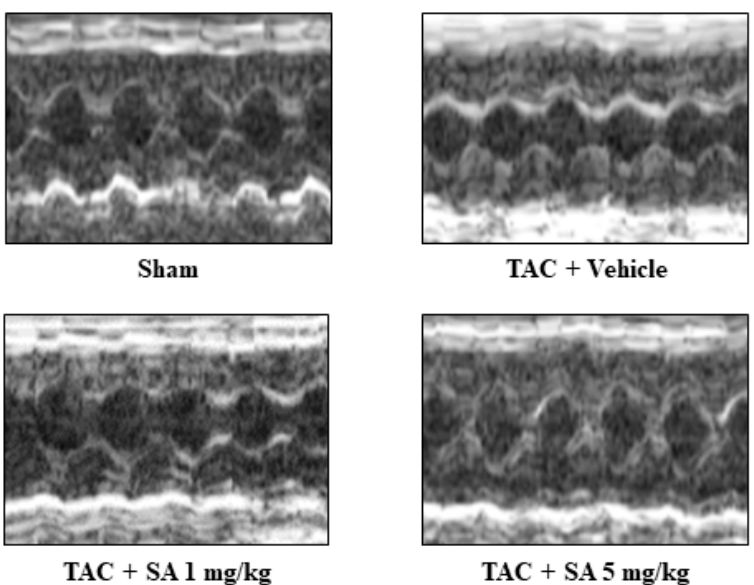
Figure 3. Sarpogrelate suppressed TAC-induced cardiac hypertrophy and systolic dysfunction in vivo. Eight weeks after TAC surgery, cardiac hypertrophy and cardiac function were assessed by echocardiography. Representative images of echocardiography from sarpogrelate- and vehicle- treated TAC and sham are shown. Table 1. Echocardiographic parameters of sham and TAC mice. Sham TAC Vehicle Vehicle SA 1 mg/kg SA 5